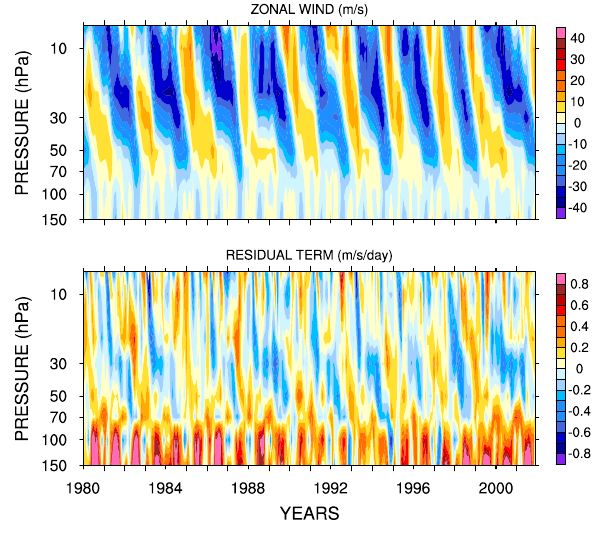
Fig. 4. Hovm¨oller diagram of the equatorial (averaged between 10 ◦ S–10 ◦ N) zonal-mean zonal wind (ms − 1 ) and of the residual term (ms − 1 day − 1